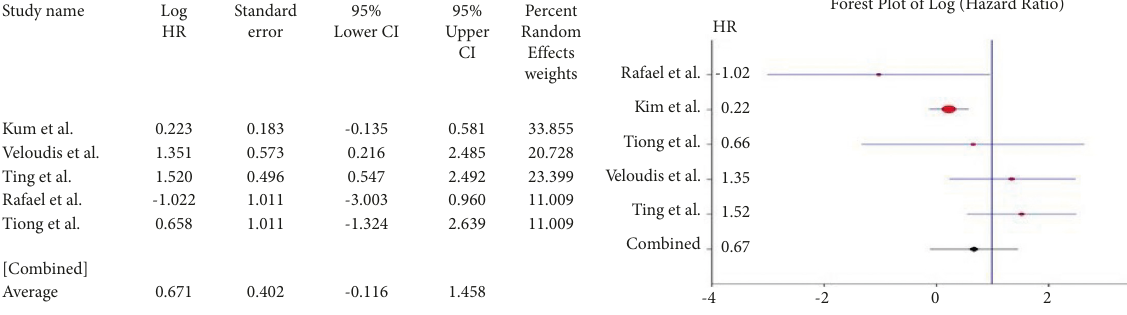
Figure 6: Forest plot of WNT gene and overall survival in